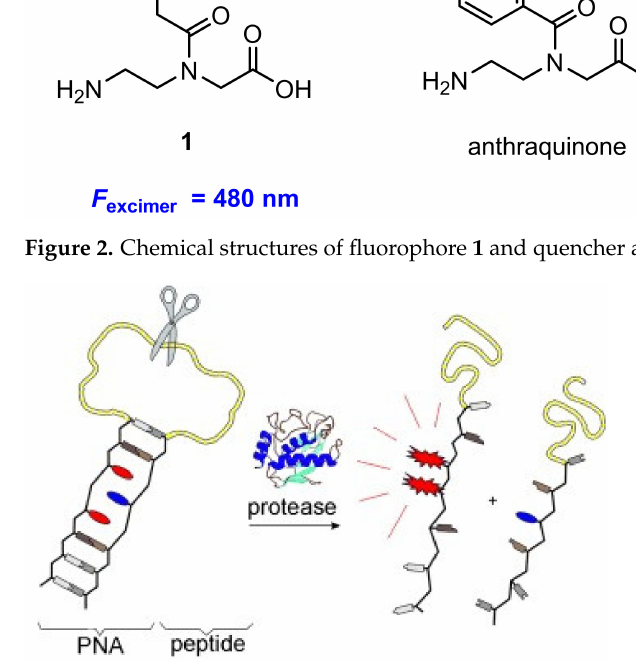
Figure 3. Schematic representation for the detection of protease (fluorophore 1 , red color in PNA; quencher anthraquinone, blue color in PNA) [33].